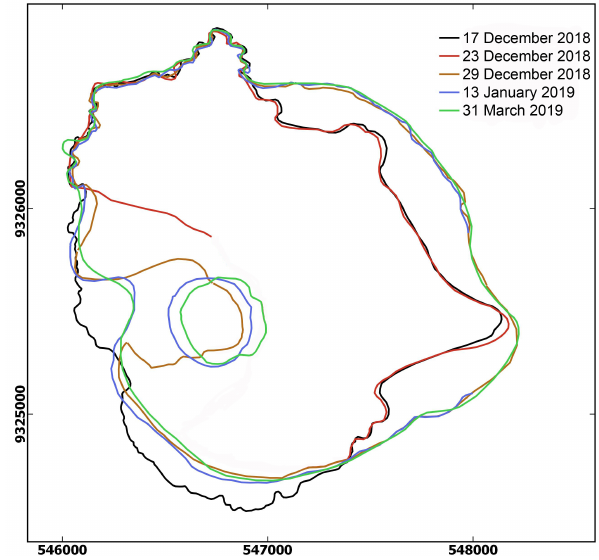
Figure 4: Shoreline evolution of Anak Island